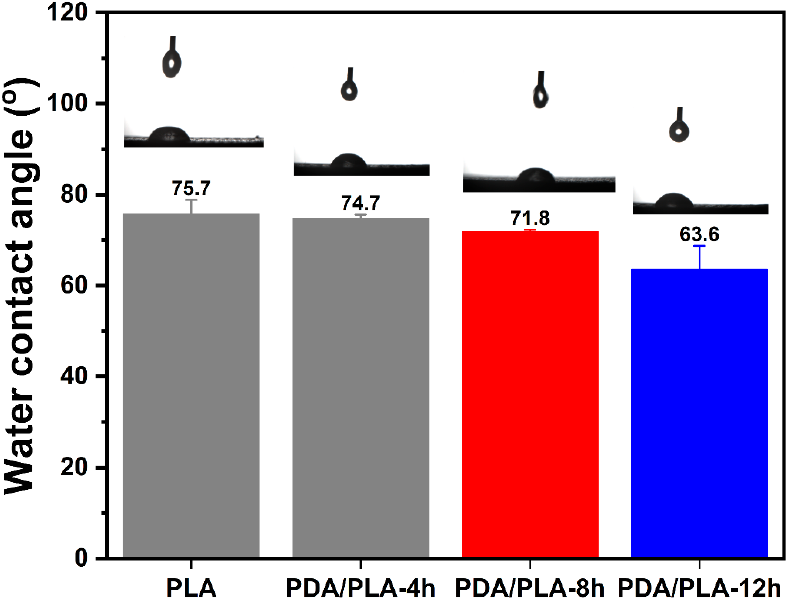
Figure 5. The water contact angle of PDA/PLA scaffolds with different immersion times in poly(dopamine).